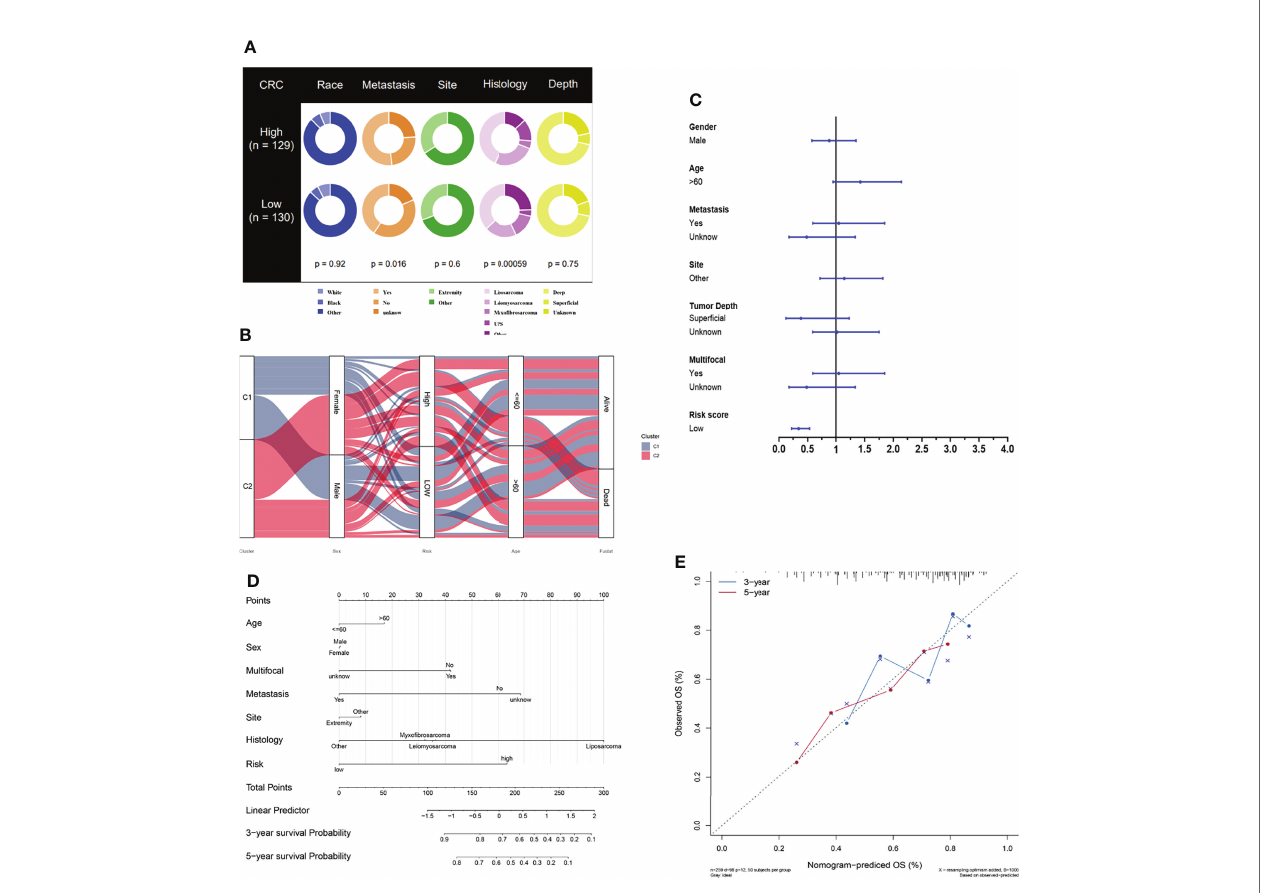
FIGURE 7 | Development of necroptosis-based prognostic model. (A) Clinical characteristic between low-risk and high-risk groups. (B) Alluvial diagram illustrating the relationship of necroptosis-based cluster distribution, clinical characteristics, different risk groups and survival outcomes. (C) Multivariate Cox regression analysis of clinical characteristics and necroptosis-based risk score. (D) Nomogram predicting 3-years and 5-years survival rate of STS patients. (E) Calibration curve for predicting OS rate of STS